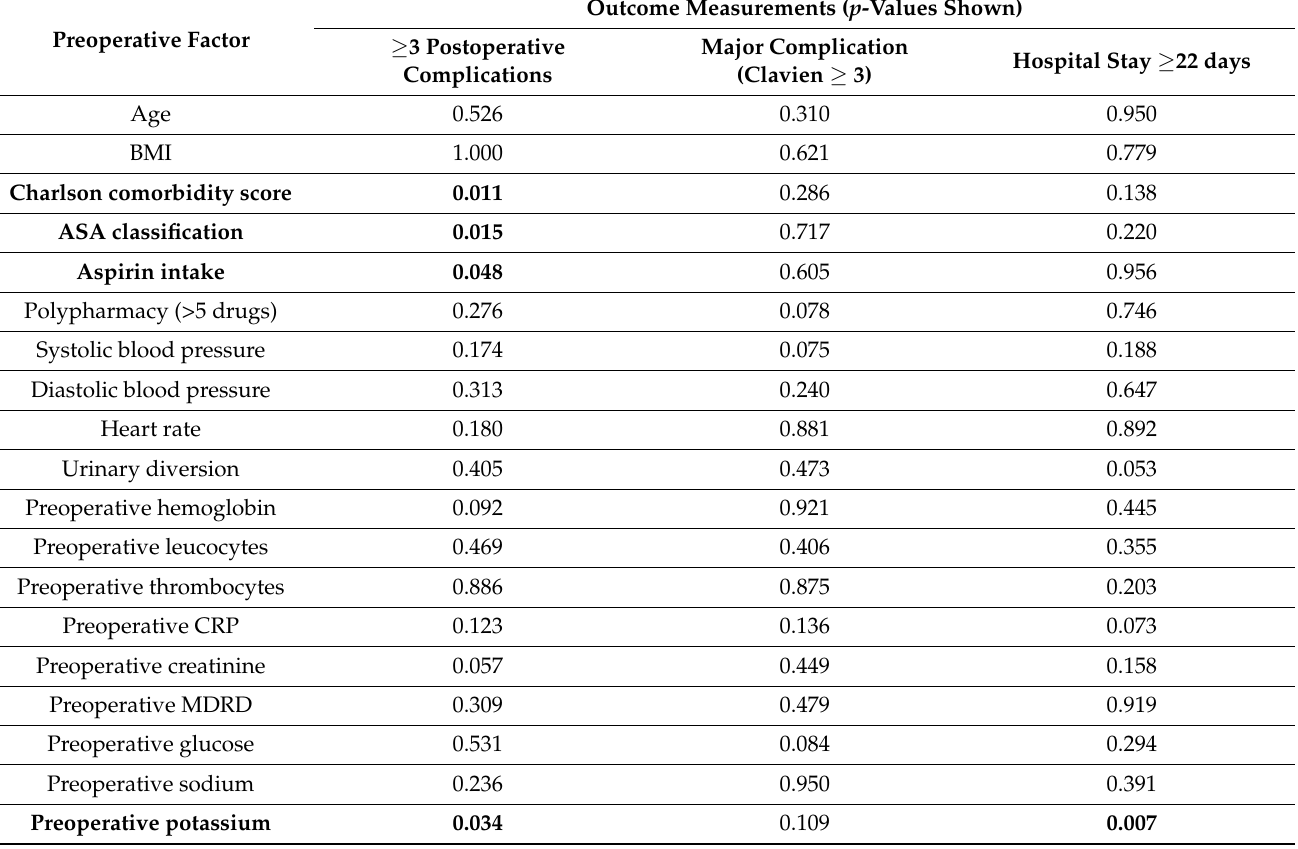
Table 2. Univariate analysis of the association between preoperative factors and postoperative outcome measurements. p -values are presented. Statistically significant results are marked in bold.